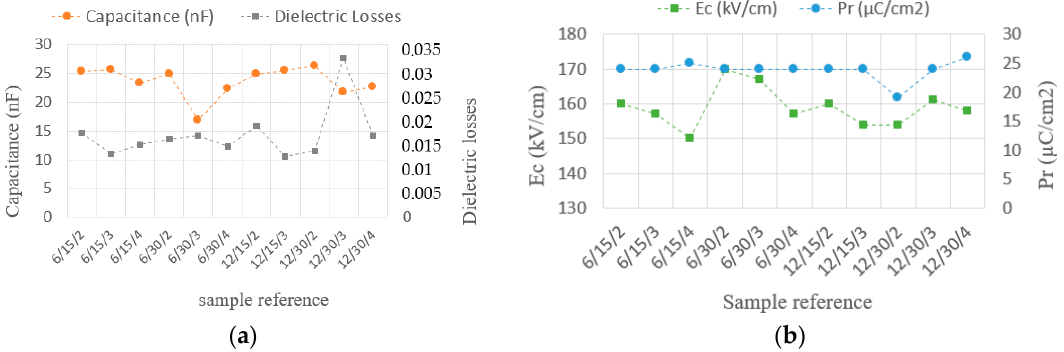
Figure 6. ( a ) Values of the capacitance and the dielectric losses of the fabricated samples; ( b ) Coercive field and remnant polarization of the fabricated samples.